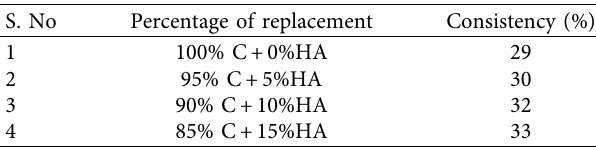
Figure 5: (a) Compressive test. (b) Tensile split test. (c) Flexural test. Table 7: The consistency of concrete pastes comprising hybrid